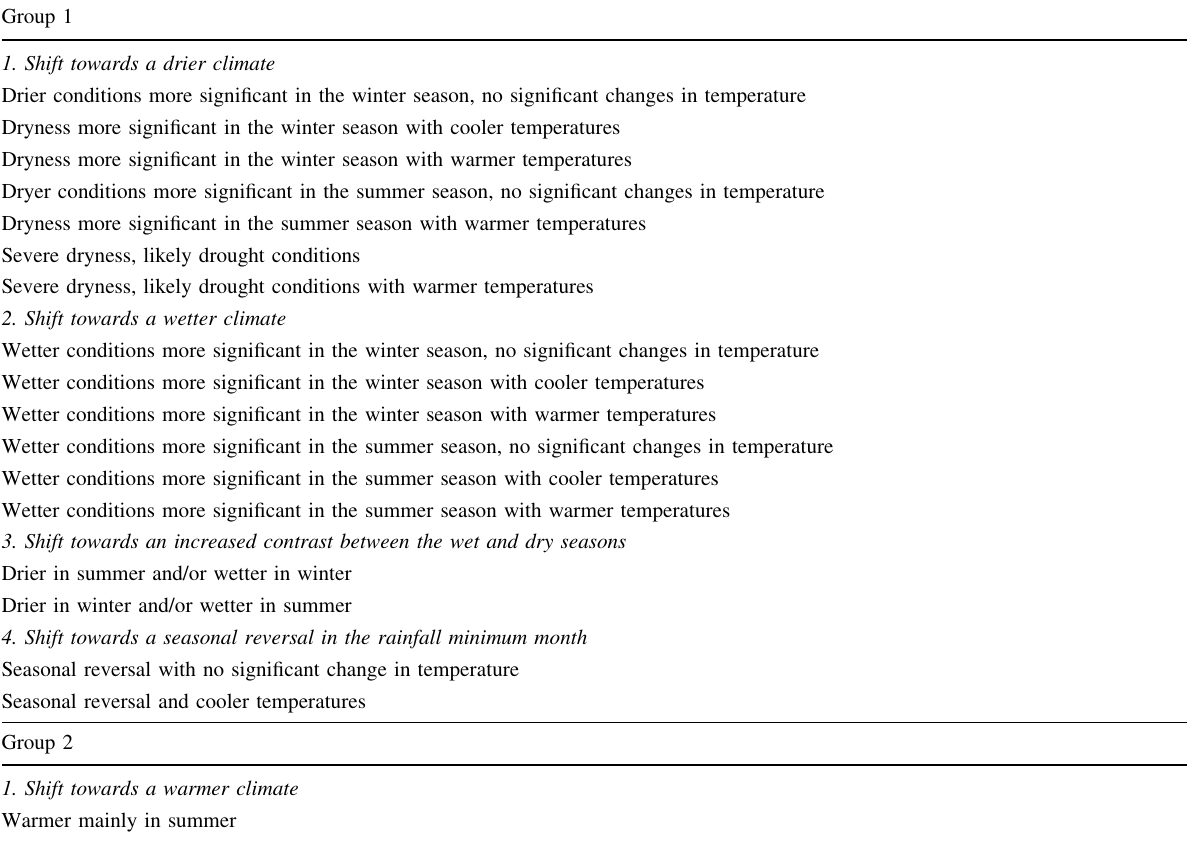
Table 2 El Nin˜o climate shift typology based on the Ko¨ppen–Geiger classification Group